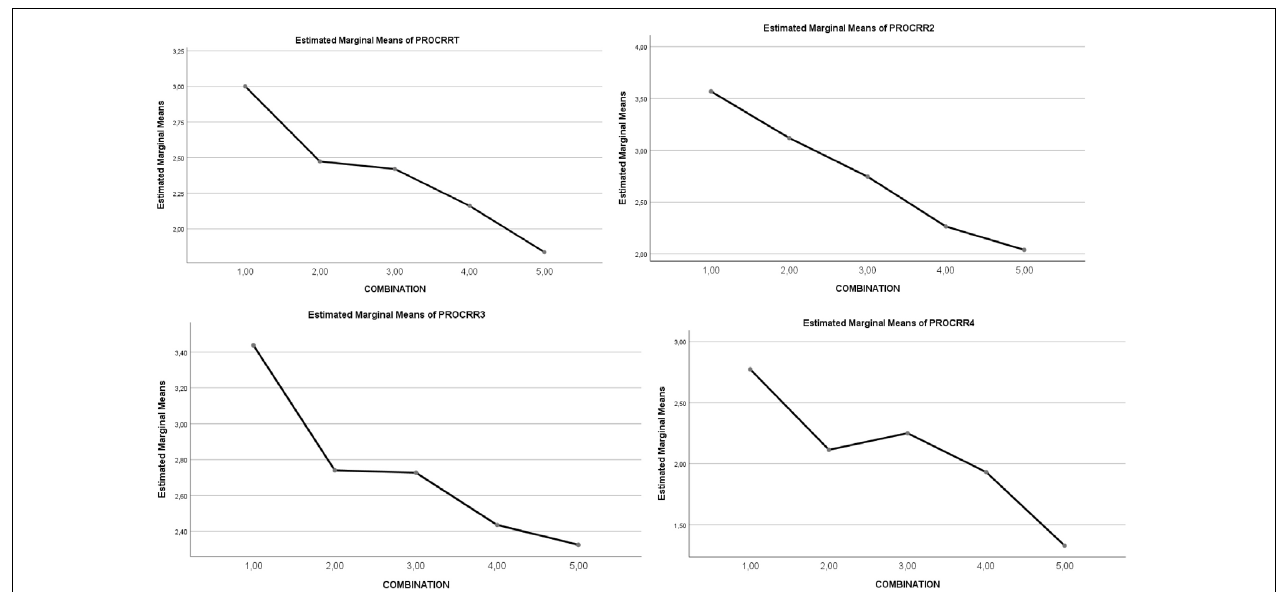
FIGURE 3 | Graphical representation of the effect of combination types (1–5) on reasons to procrastinate. Reasons to procrastinate: RF1. AROUSAL SEEKING; RF2. LOW CONTROL; RF3. PERFECTIONISM; RF4. TEST ANXIETY; RF5. LOW